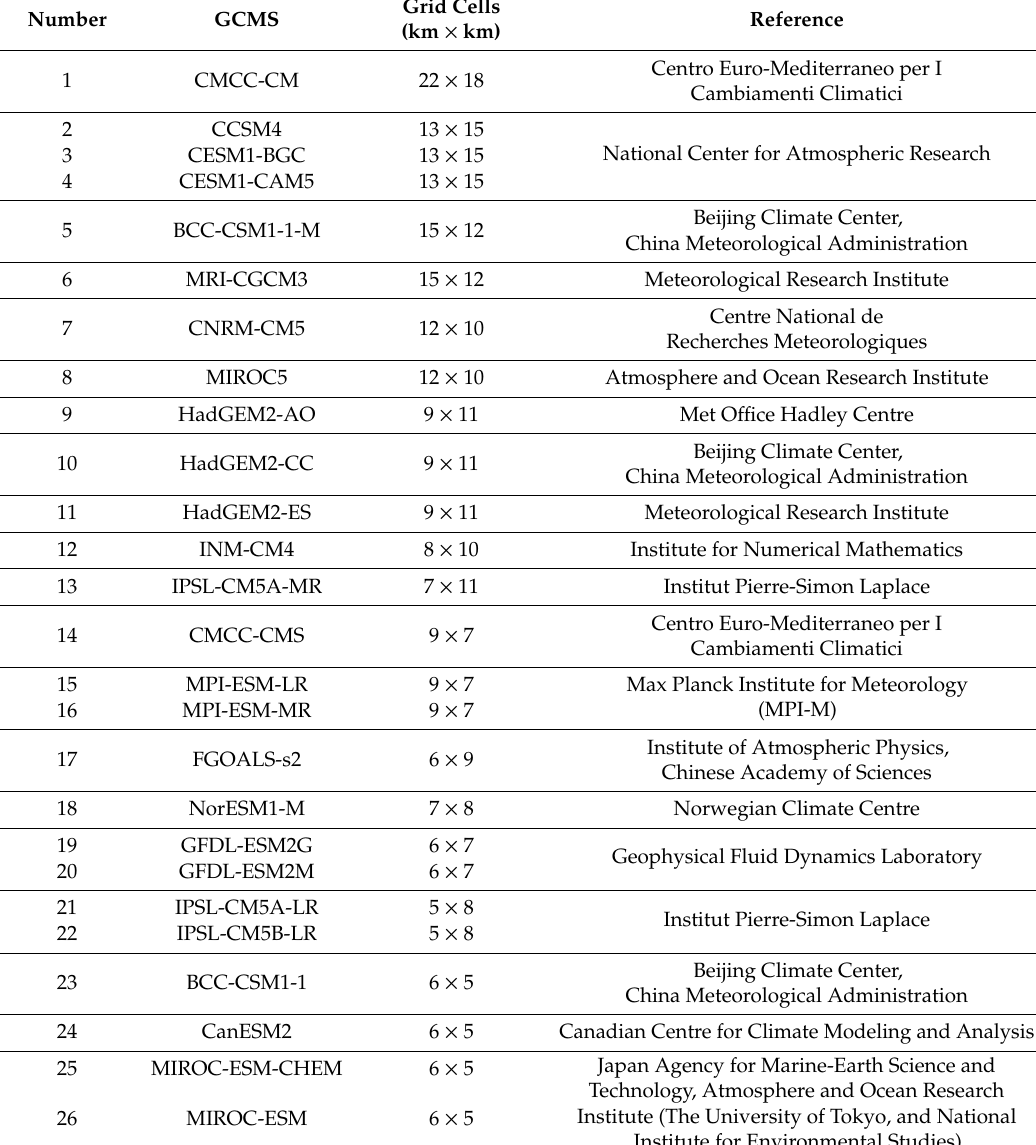
Table 1. Description of the 26 Coupled Model Inter-comparison Project 5 (CMIP5) Global Circulation Models